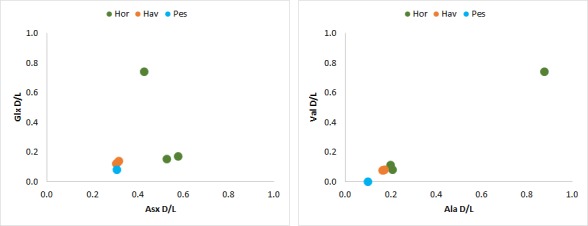
Total hydrolysable amino acid D/L values for all double-buttons (Glx vs Asx, left; Val vs Ala, right).